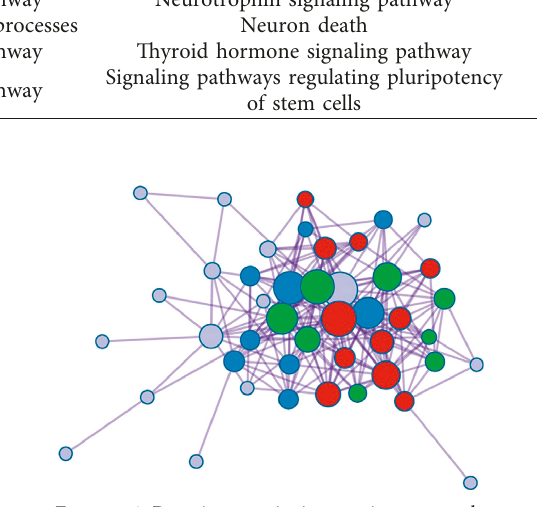
Figure 6: Protein-protein interaction